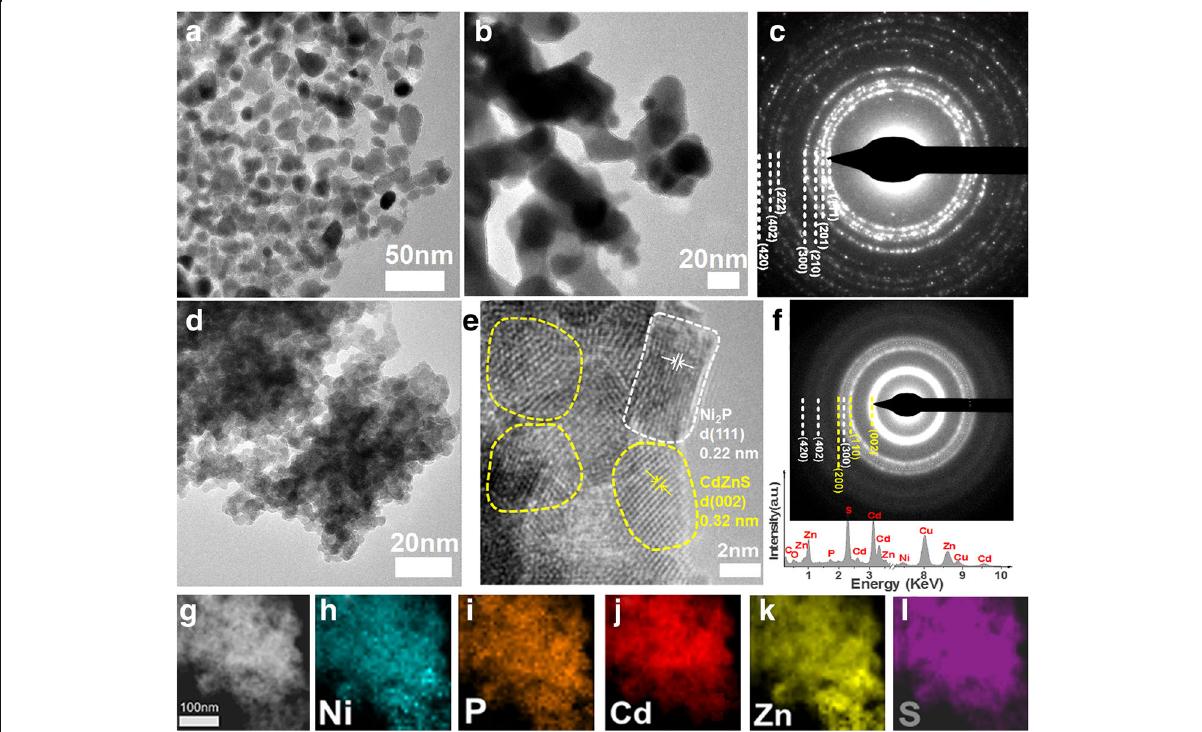
Fig. 2 Microstructure of Ni 2 P and Ni 2 P-Cd 0.5 Zn 0.5 S composite. a – c and d – f Different-magnification TEM images and SAED pattern of Ni 2 P and Ni 2 P-Cd 0.5 Zn 0.5 S, the inset f is EDX spectrum, where the yellow and white dash lines denote Cd 0.5 Zn 0.5 S and Ni 2 P, respectively. g High-angle annular dark field (HAADF)-STEM image, and h – l the corresponding EDX mappings of Ni 2 P-Cd 0.5 Zn 0.5 S